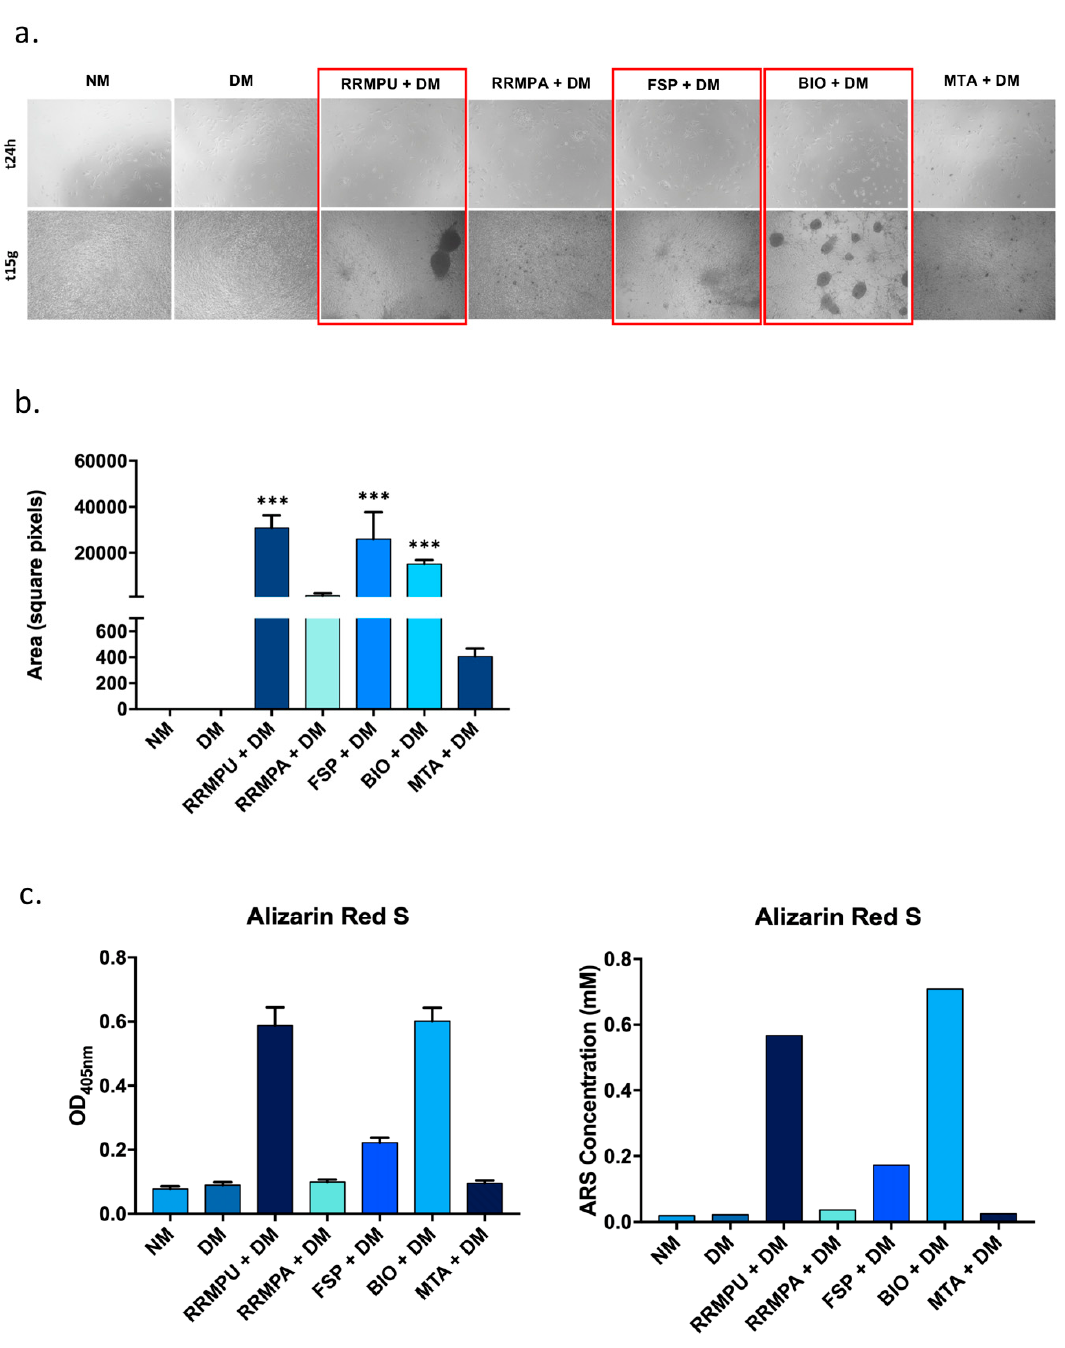
Figure 3. Formation of mineralized nodules. The presence of biomaterials enhanced the formation of mineralized nodules. ( a ) Mineralized nodules were detected in MG-63 cells grown in direct contact with RRMPU, BIO or FSP, as highlighted in red. ( b ) The area of nodules was increased in RRMPU, FSP and BIO cultures ( p < 0.001 ***). ( c ) Alizarin Red S staining demonstrated that biomineralization increased when cells were cultured in direct contact with RRMPU ( p < 0.0001 ***), BIO ( p < 0.0001 ***) or FSP ( p = 0.0012 ***). Alizarin Red S is expressed as absorbance at 405 nm (left) and as mM concentration (right).